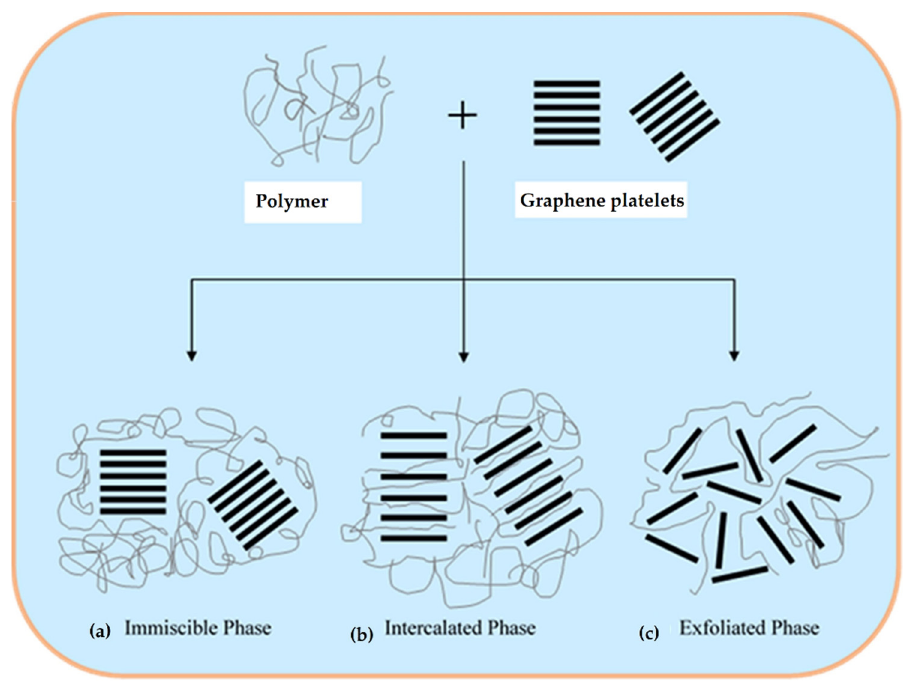
Figure 3. Schematic showing three morphological states for graphene-based polymer nanocomposites. ( a ) Immiscible phase. ( b ) Intercalated phase. ( c ) Exfoliated phase.